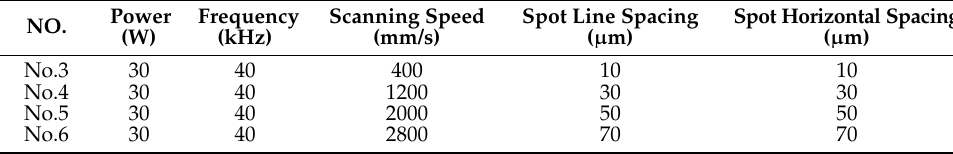
Table 1. Experimental parameters for laser surface